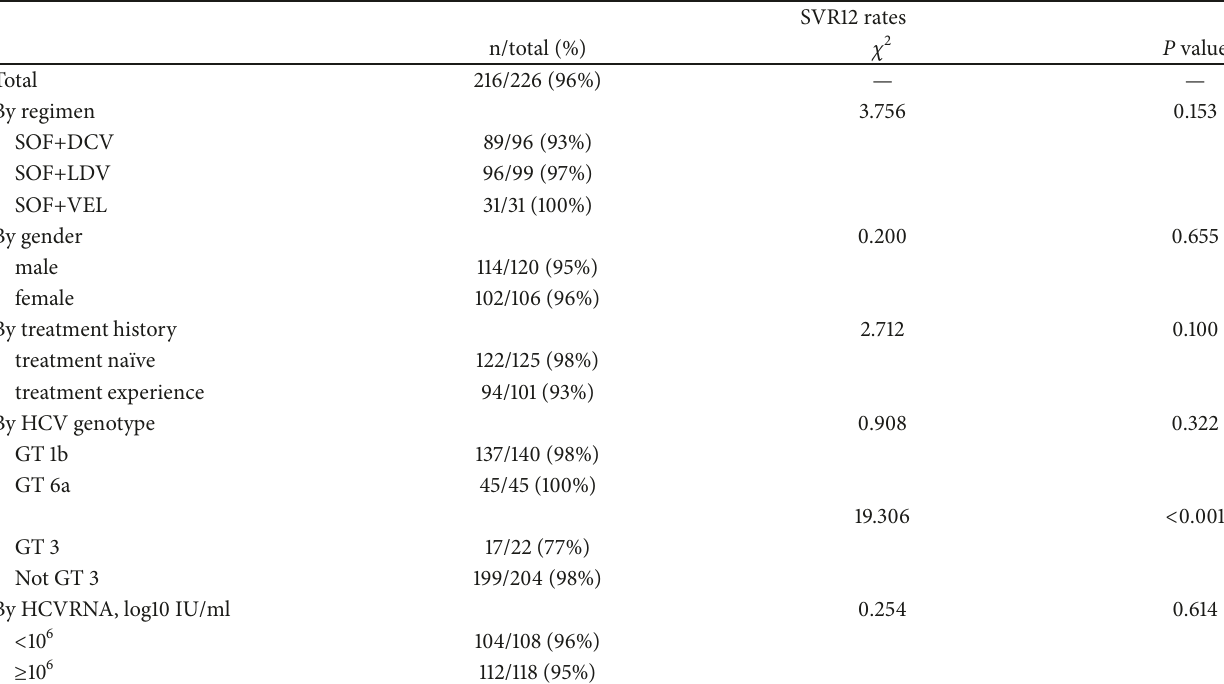
Table 3: SVR12 by baseline factors.